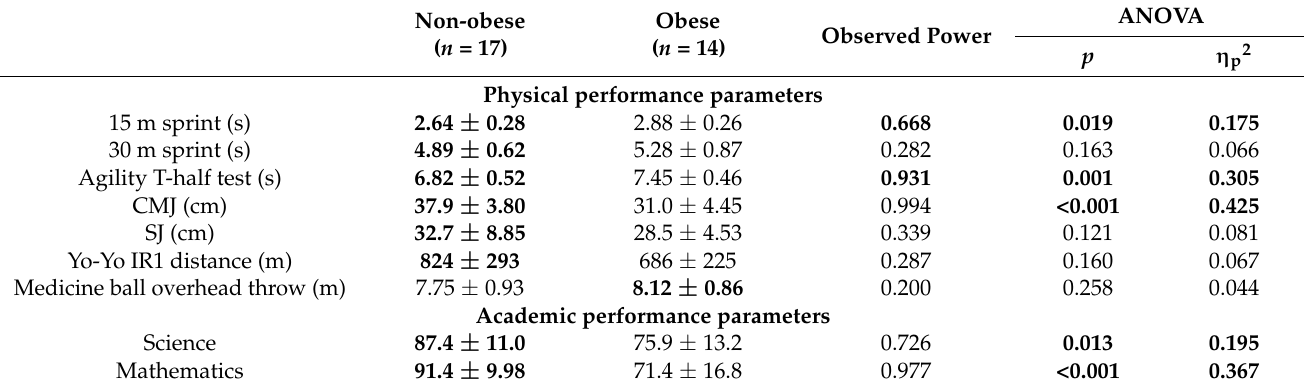
Table 3. Comparison of physical and academic performance parameters between two groups. Data are presented as mean ± SD. Meaningful effects (criteria: p < 0.05 and η p2 > 0.15 and observed power >0.60) and performance maxima marked in